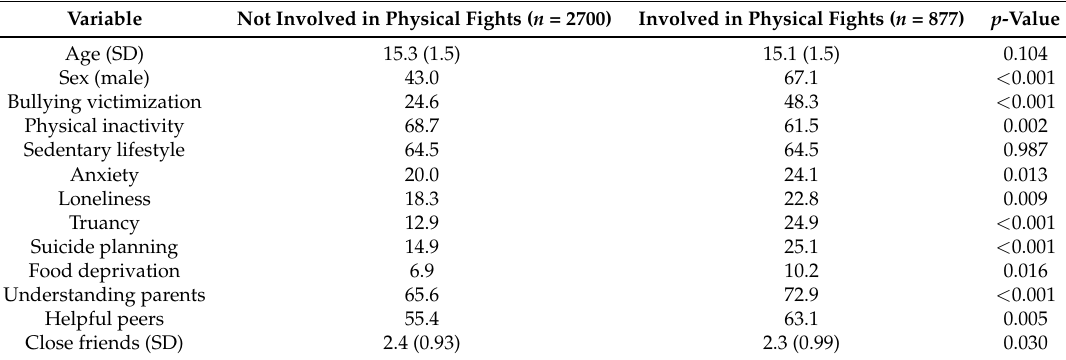
Distribution of selected factors according to categories of physical fighting among school-attending adolescents in Kuwait, GSHS